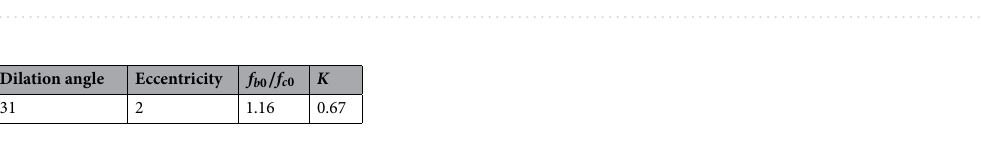
Figure 7. Numerical model components: ( a ) concrete part, ( b ) Steel beam, ( c ) Reinforcement bars, ( d ) Rigid plate.